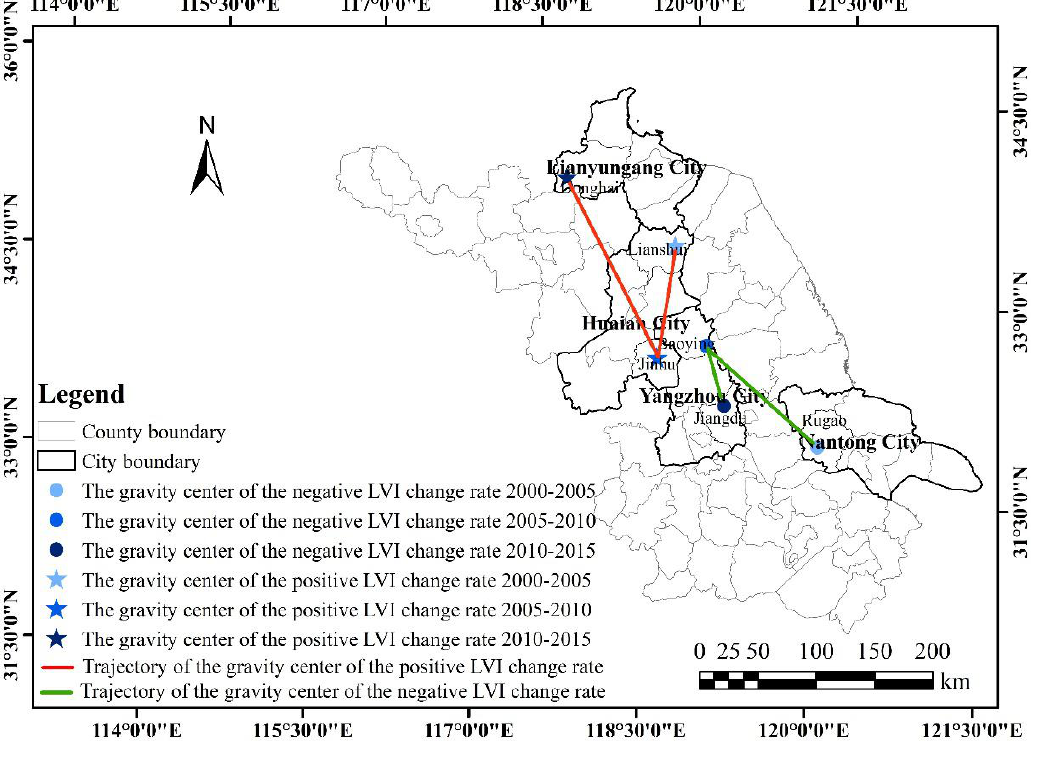
Figure 3. The trajectories of gravity centers of positive and negative landscape vulnerability index (LVI) change rates. Table 2. Moving distances and directions of gravity centers.